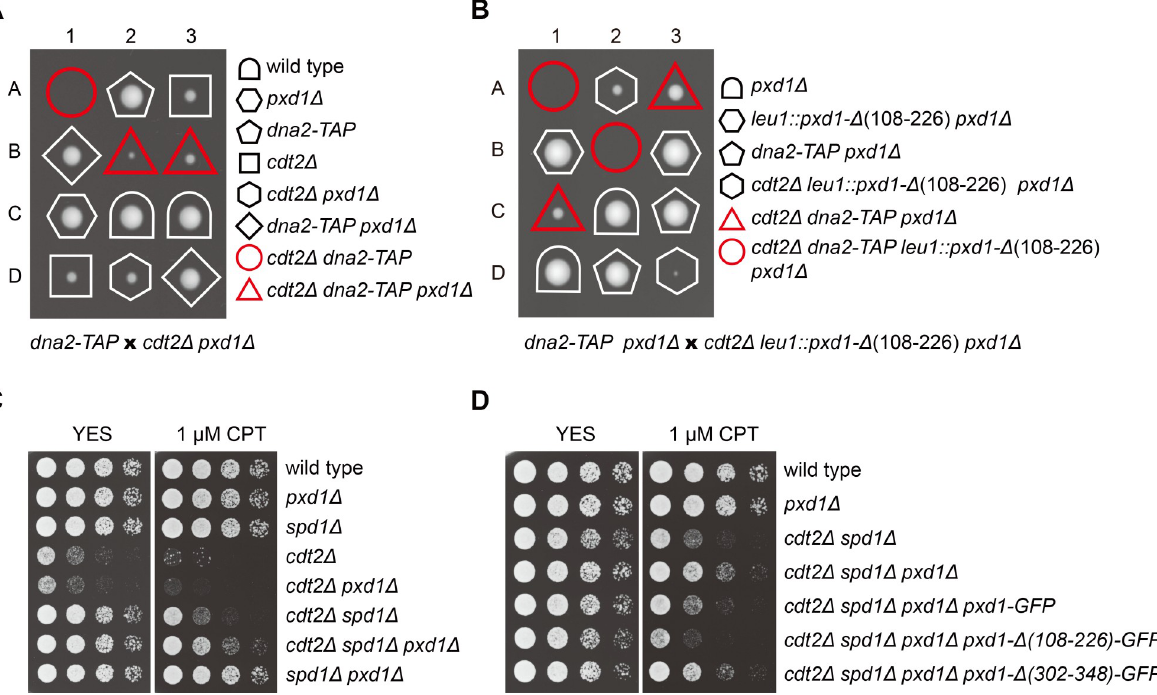
Fig 5. Loss of Cdt2 interferes with the S-phase functions of Dna2. (A) cdt2 Δ was synthetic lethal with dna2-TAP and this synthetic lethality was suppressed by the deletion of pxd1 . (B) Introducing truncated Pxd1 with only Dna2-inhibition activity into the cdt2 Δ dna2-TAP pxd1 Δ mutant resulted in lethality. (C) The deletion of pxd1 suppressed the CPT sensitivity of the cdt2 Δ spd1 Δ mutant. Serial dilutions of strains were spotted on YES plates without and with CPT. (D) Introducing truncated Pxd1 with only Dna2-inhibition activity but not truncated Pxd1 with only Rad16-activation activity enhanced the CPT sensitivity of the cdt2 Δ spd1 Δ pxd1 Δ mutant.